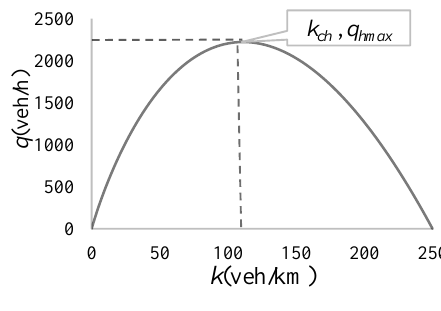
Figure 2. q - k diagram with p = 0.